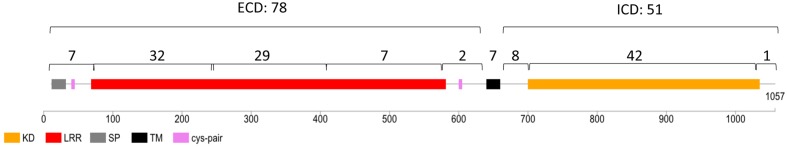
Number of sites under positive selection in SG_III, XI, or XIIIb per domain. Schematic representation of a LRR-RLK receptor containing around 20 LRRs.